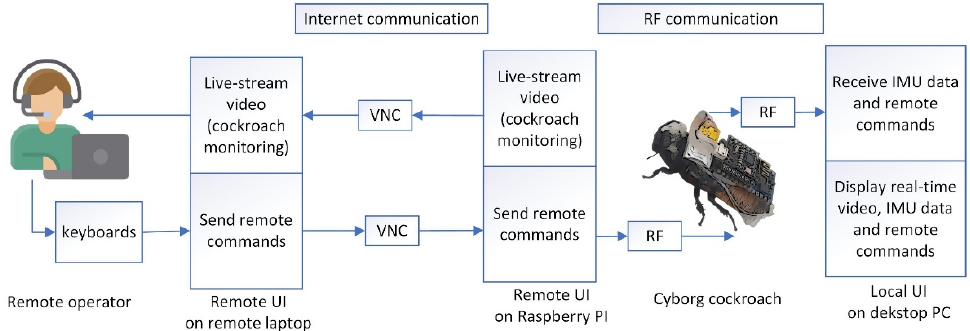
Figure 10. Internet and RF wireless communication channels on the biobot teleoperation system .